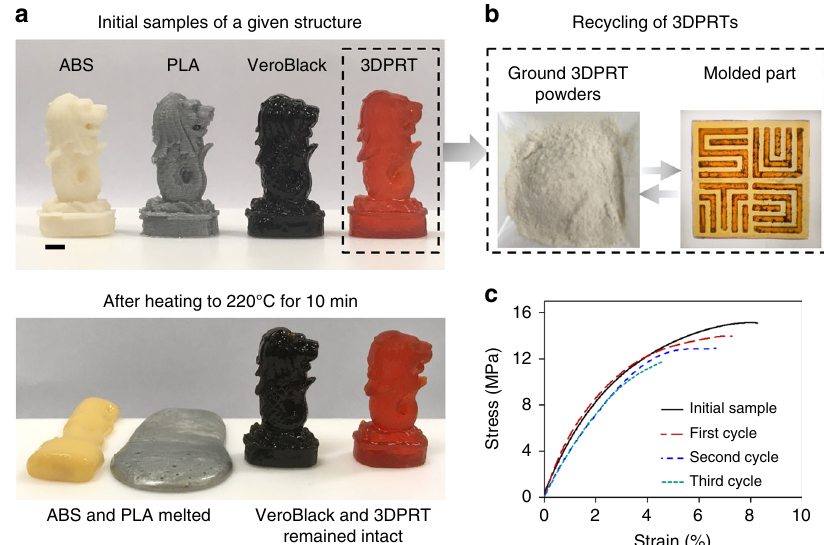
Fig. 4 Recyclability of 3D printing reprocessable thermosets. a Stability comparison of a printed structure with 3DPRT and structures printed with commercial available thermoplastics (PLA and ABS) and thermoset (Vero-black) at high temperature (220 °C). b Demonstration of recycling of a structure printed with 3DPRT. c Uniaxial tensile tests to examine the mechanical repeatability of the recycled 3DPRTs. Scale bar: 5